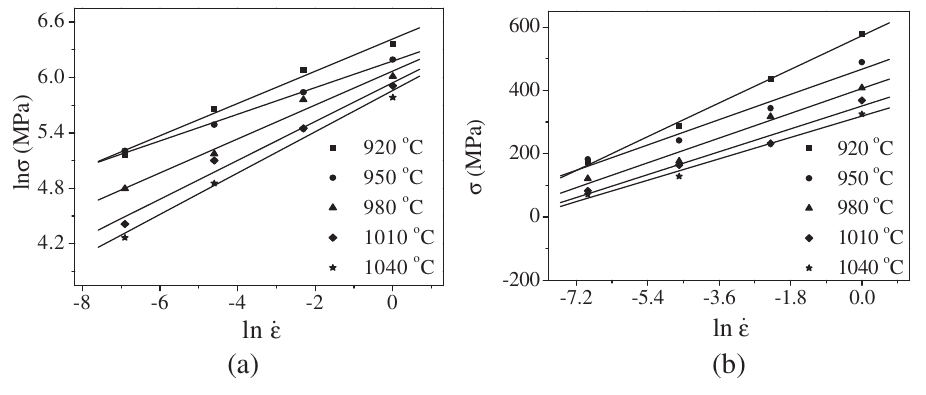
Figure 2: Relationships between: (a) ln σ ~ ln _ ε ; (b) σ ~ ln _ ε .